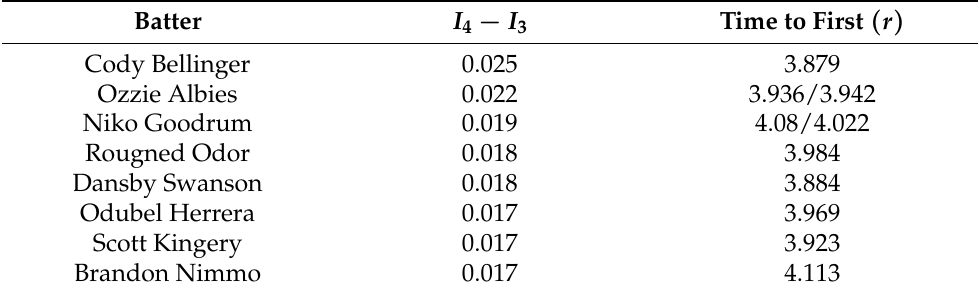
Table 5. Largest differences between weighted on base average (wOBA) cube and wOBA tesseract values ( I 4 − I 3 ) for 2018 and time to first ( r ) in seconds; two r values are given for